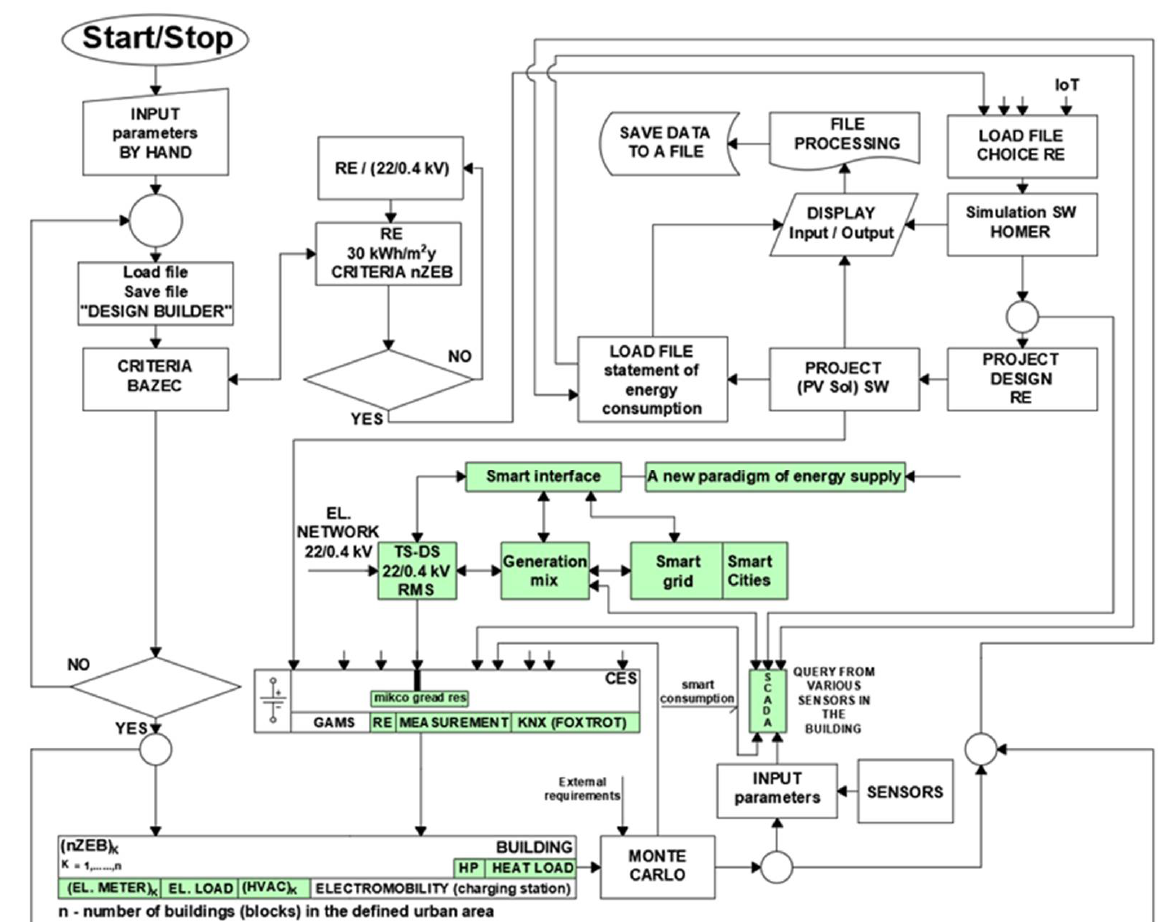
Figure 3. Smart microgrid as a strategic element of BEM.